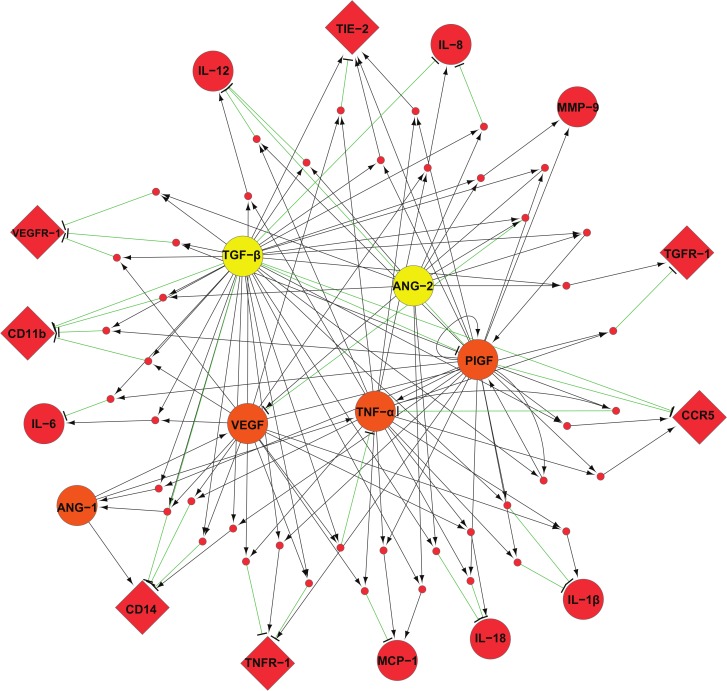
ivdTEM network topology.Dynamical models of treatments/receptors/cytokines interactions in ivdTEM. Inputs (treatments) and output (receptor and secreted soluble factors) are depicted in yellow and red respectively. Factors that were used as treatment and measured as output are depicted in orange. Combined treatments (network nodes i.e. AND) are represented as small pink circles. Stimulatory and inhibitory effects of single or combined treatments are depicted by black arrow-headed edges and green edges respectively. Circles and diamonds represent soluble factors and receptors respectively. All the links presented are provided in S4 Table. Boolean equations used for representing ivdTEM regulatory networks are provided in S6 Table.